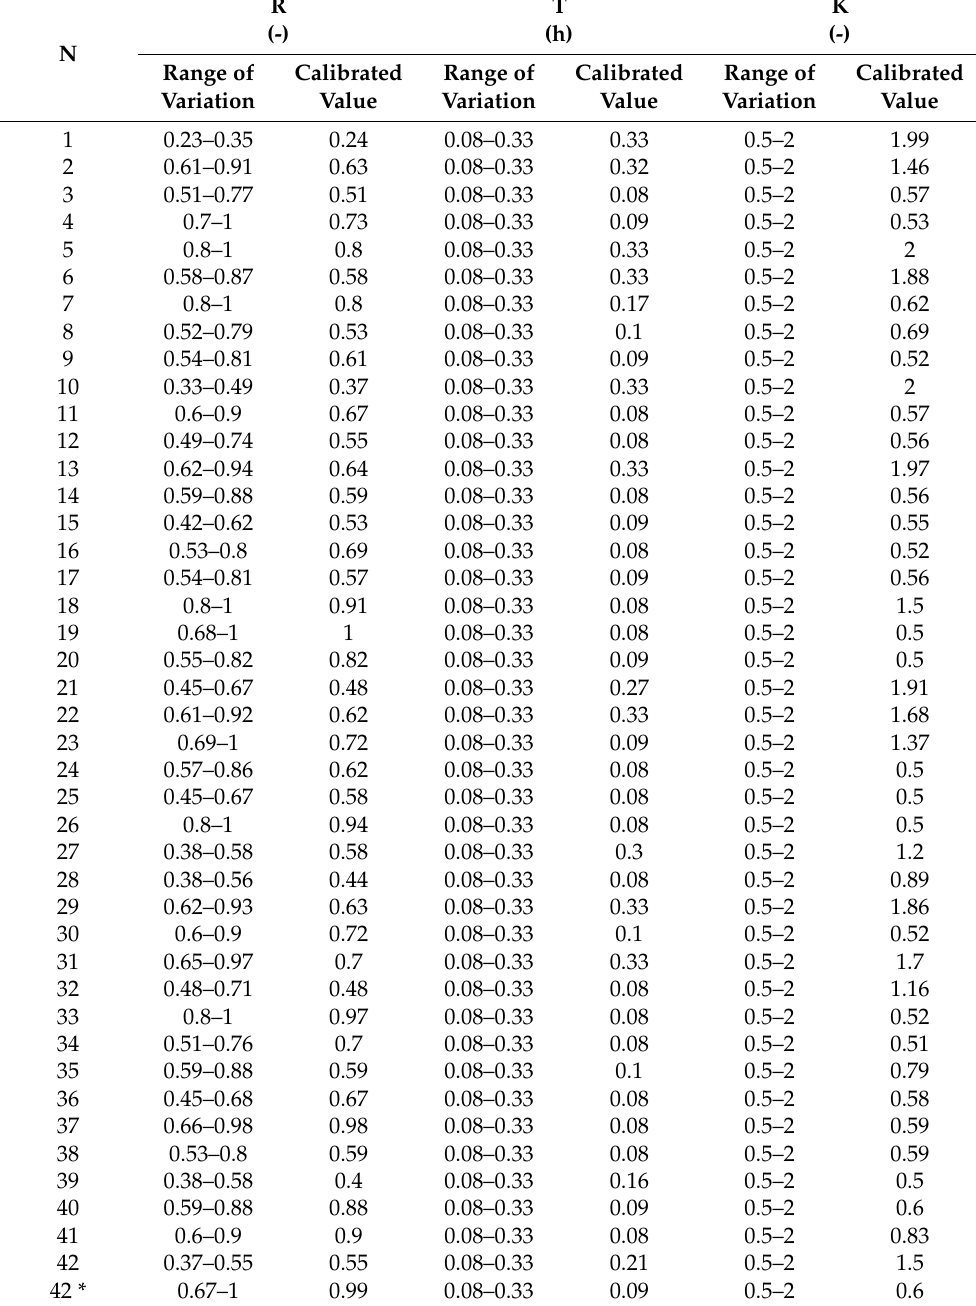
Table 4. The calibrated parameters of the UH method. (42 *) indicates the modified catchment 42 after May